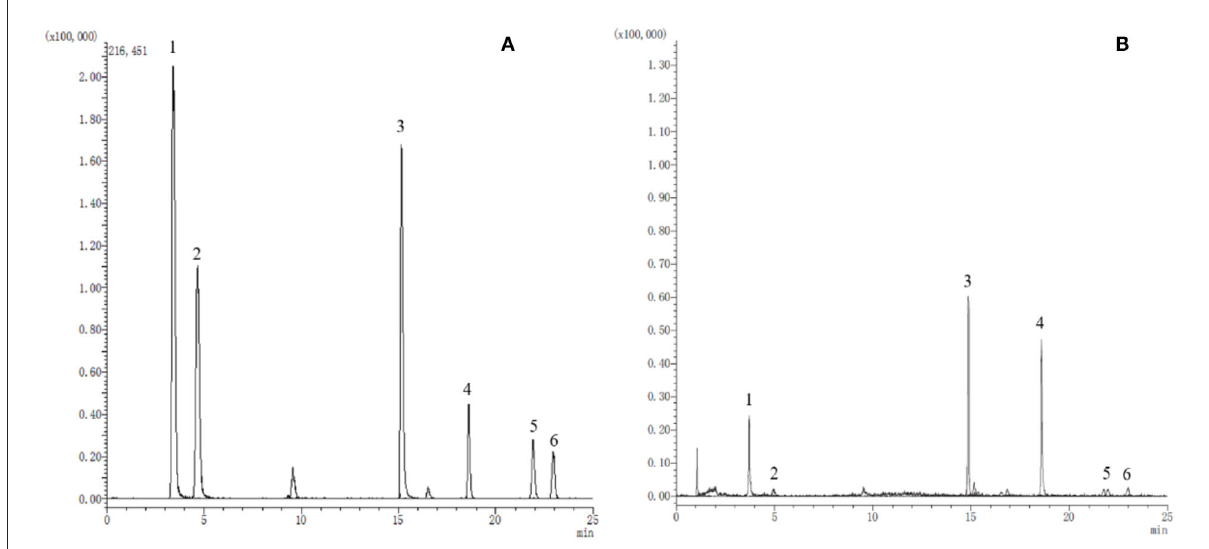
FIGURE1 The extracted ion chromatograms (EICs) of reference substances (A) and sample (B) . 1. Catechin; 2. Chlorogenic acid; 3. Hyperoside; 4. Quercetin; 5. Kaempferol; 6. Isorhamnetin.